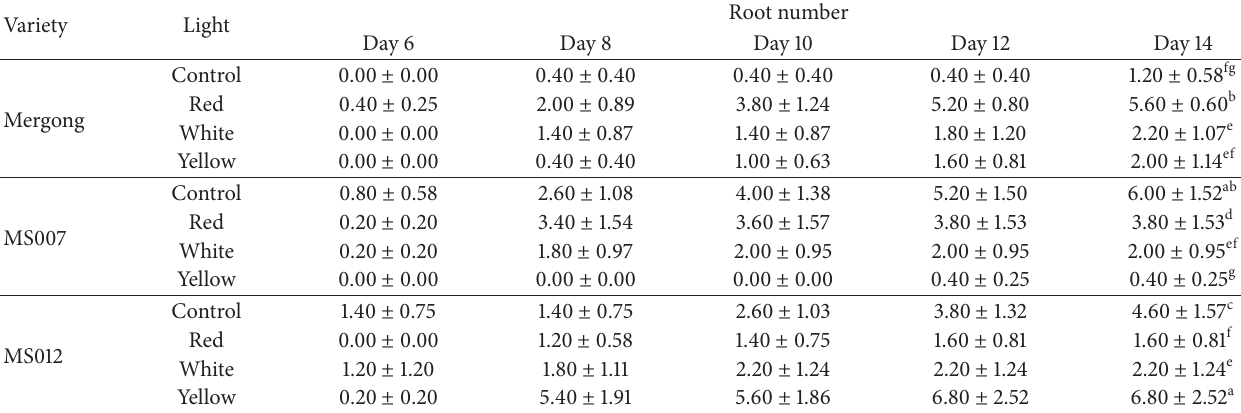
Table 9: Mean root number of three varieties treated with red, white, and yellow lights from day 6 to day 14 in mist-chamber propagation